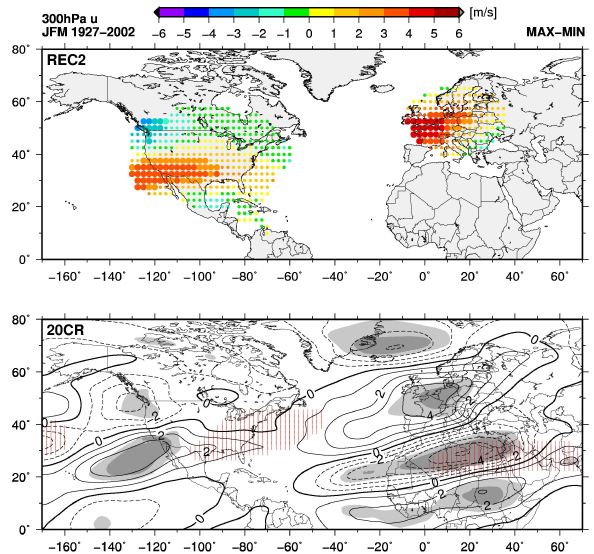
Fig. 7. Similar to Fig. 5, but showing zonal wind in ms − 1 . Red lines localise the strongest sections of the jet stream ( ≥ 30ms − 1 ) in the 1927–2002 climatology for 20CR.